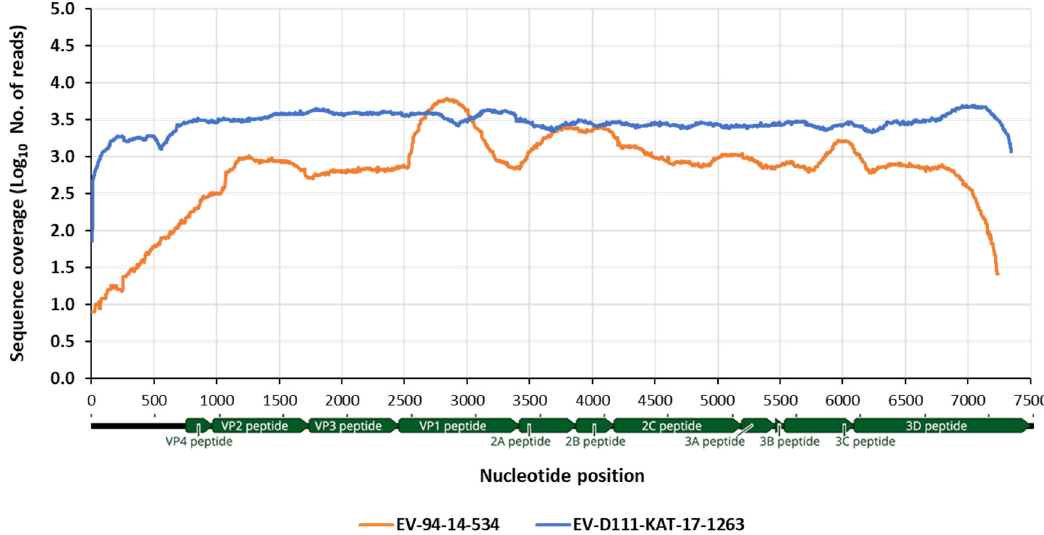
Figure 4. Genome coverage of EV-D94-14.534 strain from the Republic of Niger (orange line) and EV-D111-KAT-1263 strain from Nigeria (blue line) by NGS analysis. Filtered reads were mapped to the final consensus sequences generated by de novo assembly. The number of sequence reads at each nucleotide position is shown. The location of viral genes is indicated.